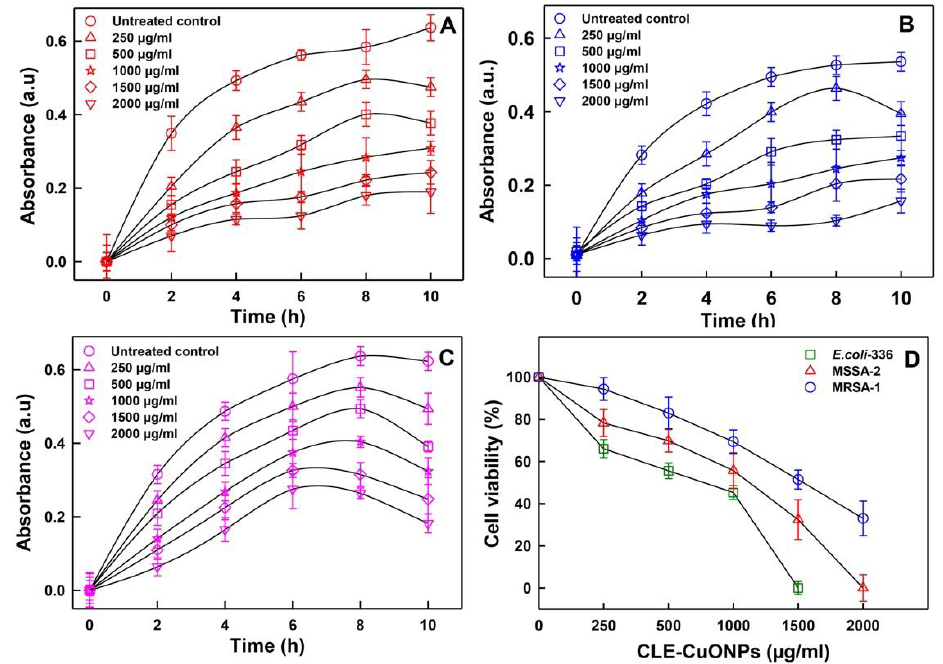
Figure 6. Antibacterial activity of CLE-CuONPs against MDR bacterial growth. Changes in the absorbance (OD 620 nm ) of clinical bacterial isolates at increasing CLE-CuONPs concentrations ( A – C ). ( A ) Gram-negative ES β L producing E. coli -336; ( B ) Gram-positive methicillin-sensitive MSSA-2, and ( C ) methicillin-resistant MRSA-1; ( D ) shows reduction in percent cell viability of clinical isolates treated with 250, 500, 1000, 1500 and 2000 μg/mL of CLE-CuONPs.